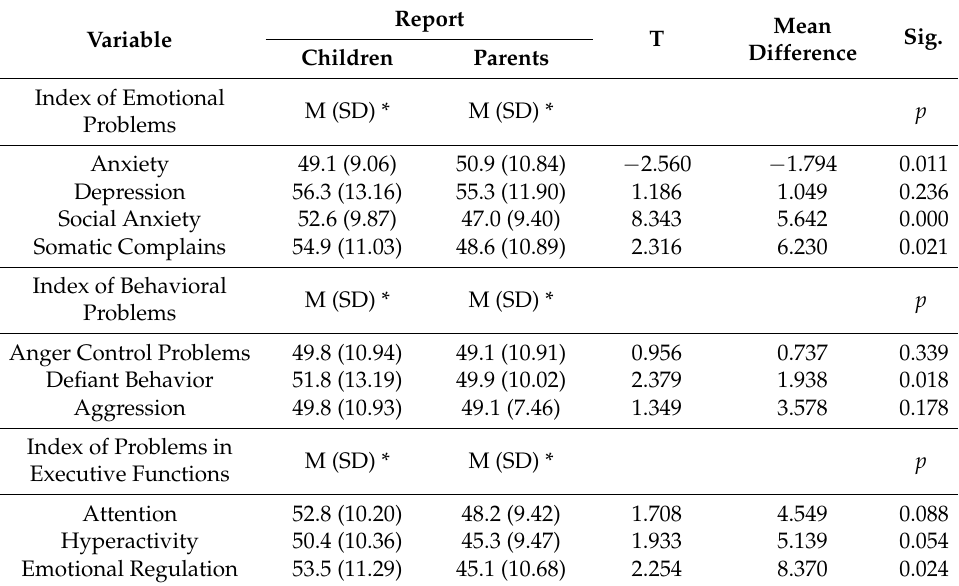
Table 3. T -test between children and parents’ report